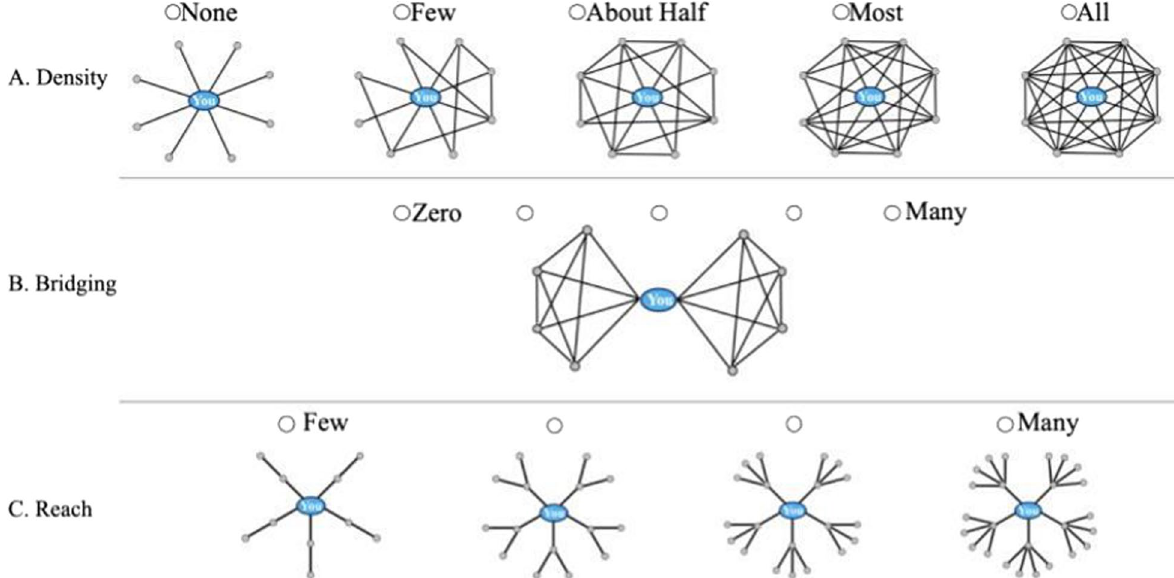
Fig. 4 Visual Network Scales survey items. Participants selected the corresponding image for each of ( a ) density, ( b ) bridging, and ( c ) reach based on their perceptions of their teaching/pedagogically related CoP network